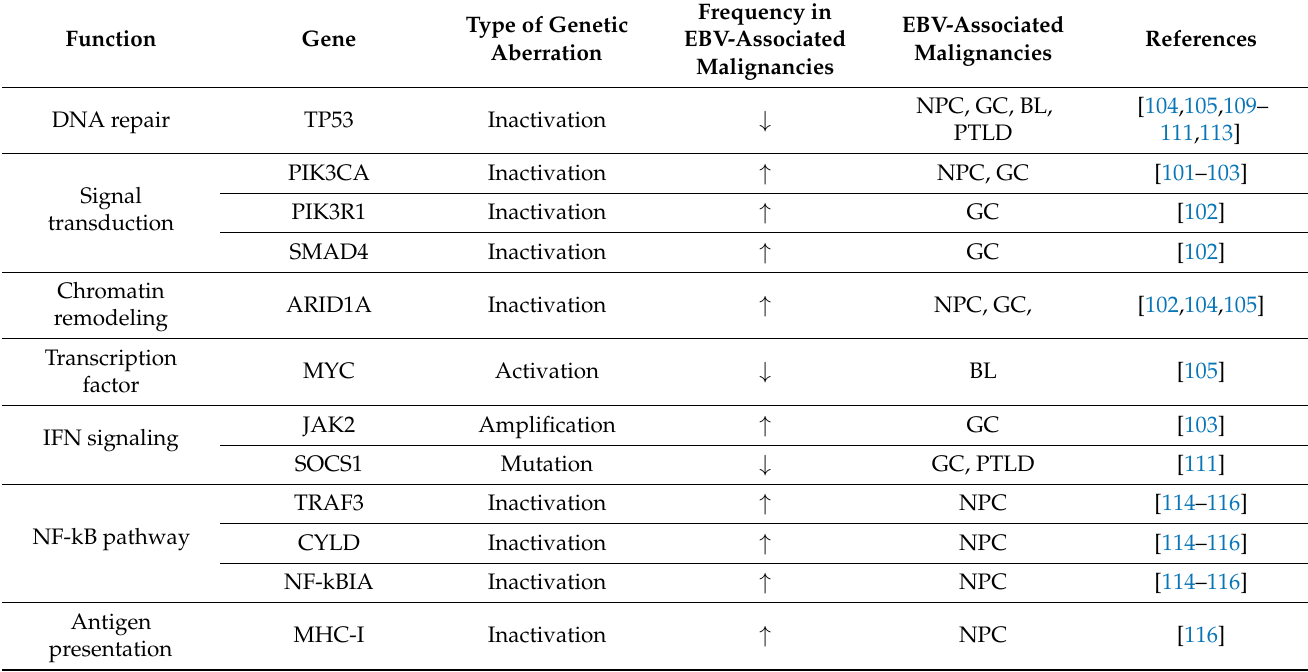
Table 3. Genetic landscape of EBV-associated malignancies. ( ↓ : down in EBV-associated malignancies, ↑ : up in EBV- associated